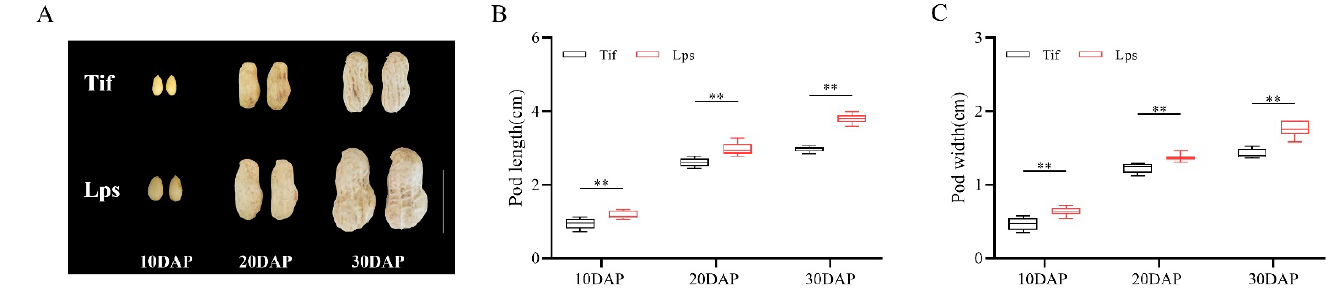
Figure 1. Phenotypes of Tif and Lps lines during pod expansion. ( A ) The phenotypic characteristics of Tif and Lps pods at three growth stages. Scale bar is 2 cm. ( B ) Pod length of Tif and Lps lines at three growth stages. ( C ) Pod width of Tif and Lps lines at three growth stages. ** p < 0.01.